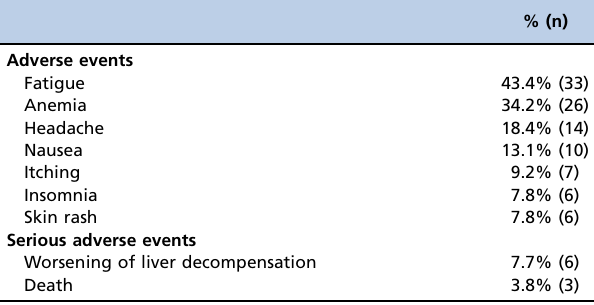
Table 4 - Safety analysis.*